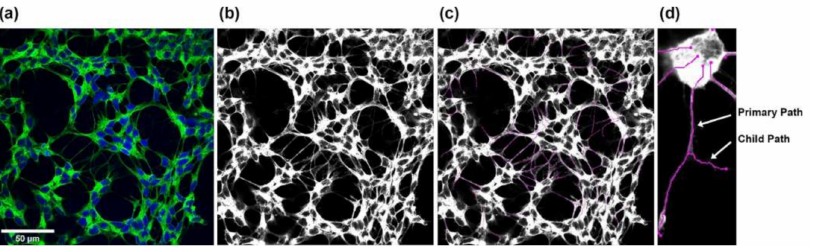
Figure 11. Steps for measuring SH-SY5Y neurite outgrowth. ( a ) RGB overlay images were merged from the individual monochrome images. ( b , c ) Starting from the corresponding grayscale images, all neurites in an image were measured using the Simple Neurite Tracer plugin from Fiji-ImageJ. ( d ) The total length of the neurites was determined by adding the main trunk (primary path) and the outgoing branches (child